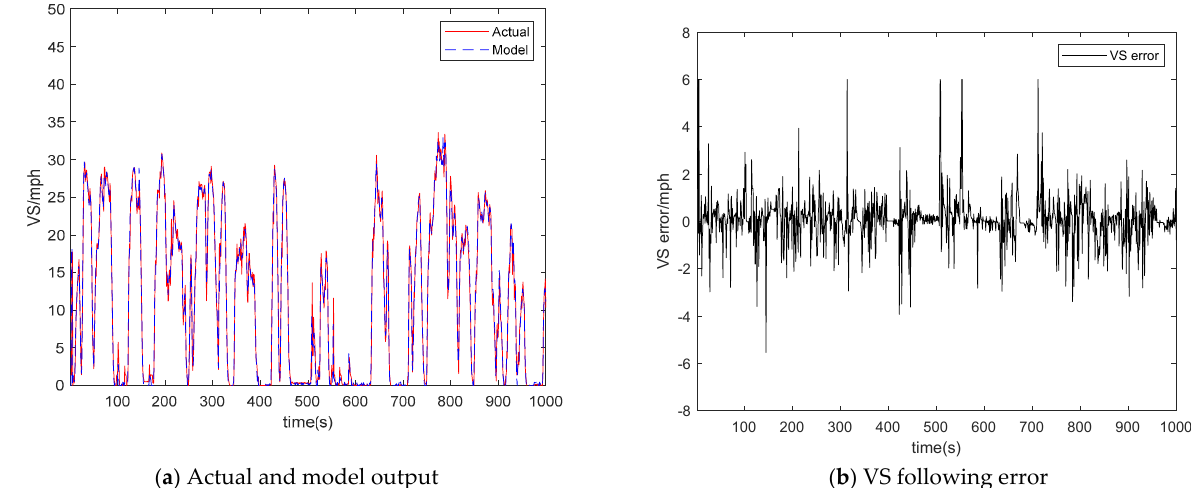
Figure 2. Vehicle model performance. ( a ) Actual and the model output vehicle speed curves; ( b ) The error between the actual and the model output vehicle speed.